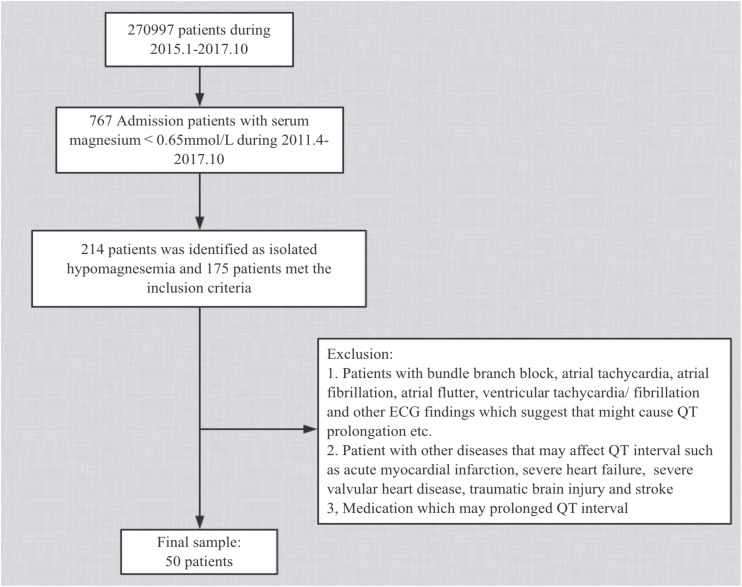
Flow chart of baseline screening of the study population.